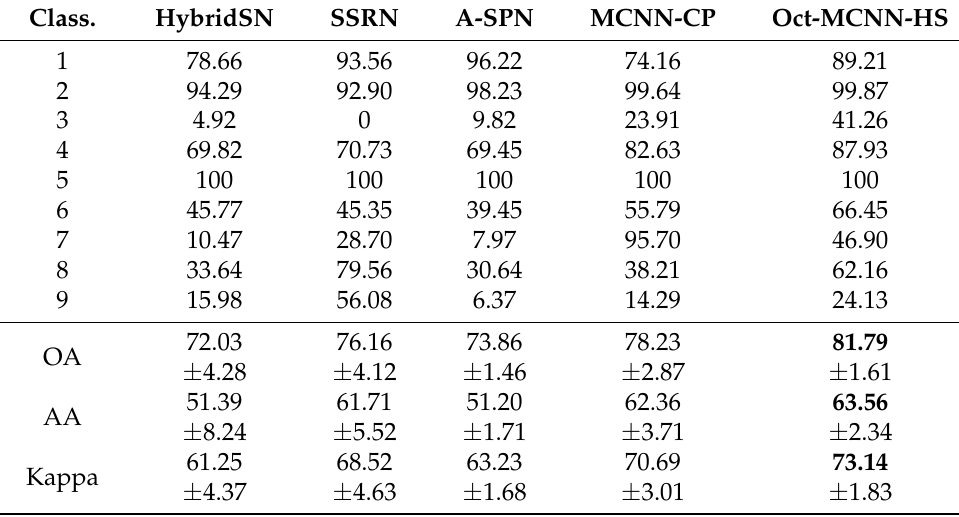
Table 8. Results (%) for the University of Pavia dataset with 0.1% training samples.